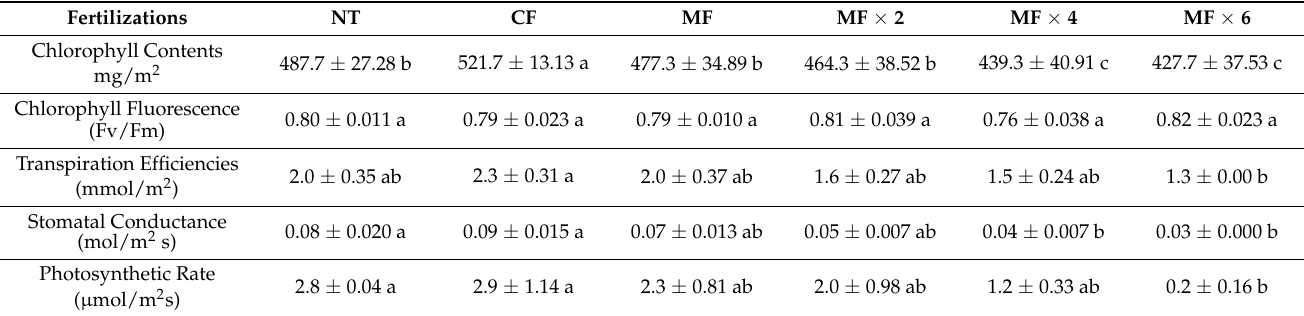
Table 3. Photosynthetic characteristics of Chinese